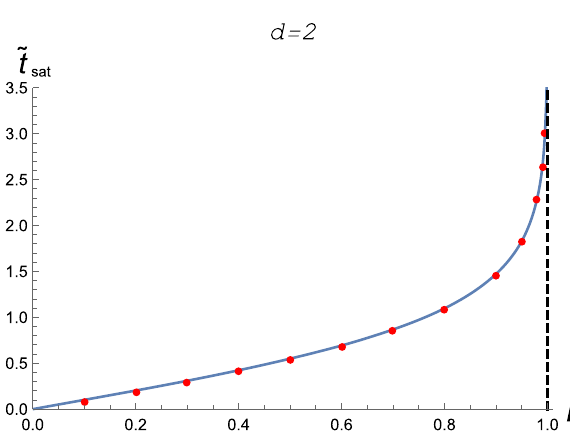
Fig. 4 Time evolution of normalised HSCV density ˆ C for various ˜ R with fixed d . The mass is fixed as M = 1 A is chosen to be a sphere on the boundary time slice. The dual extremal codimension-one hypersurface (cid:4) A in the bulk, whose volume gives the complexity of A , is found to be sim- ply swept out by the HRT surface along the ˜ r -direction. The whole time evolution of subregion complexity can be divided into four stages: It first increases almost linearly; Then its